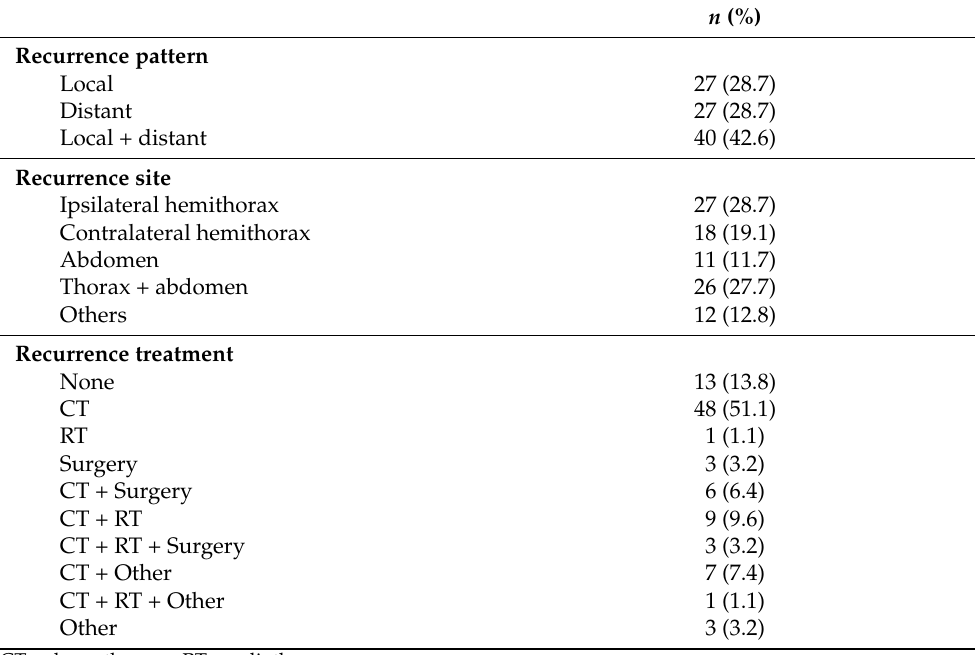
Table 2. Recurrence pattern and